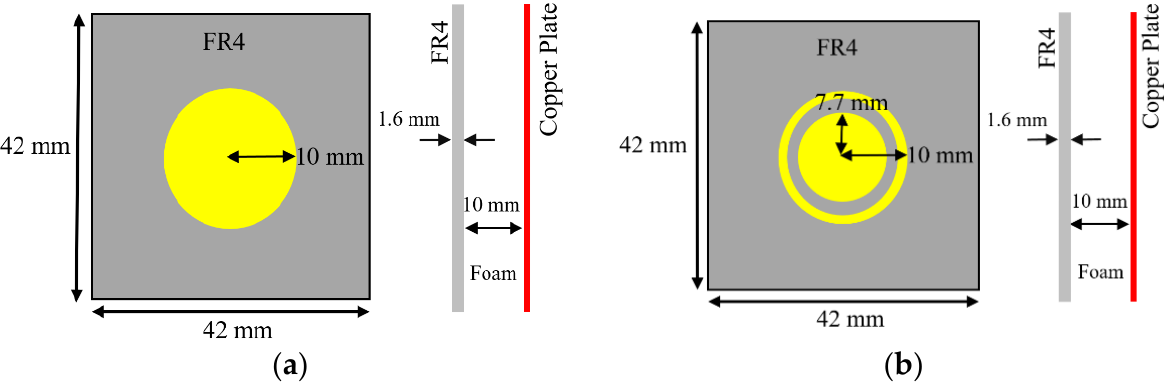
-0.35-0.3-0.25-0.2-0.15-0.1 -0.35